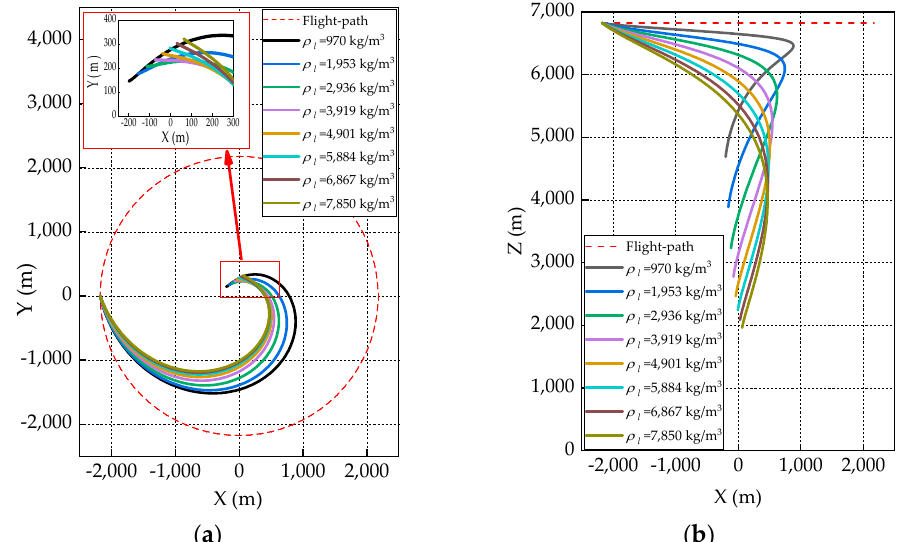
Figure 10. Towline spatial configurations vs. towline material density: ( a ) Two-dimensional projection in horizontal plane. ( b ) Two-dimensional projection in vertical plane.